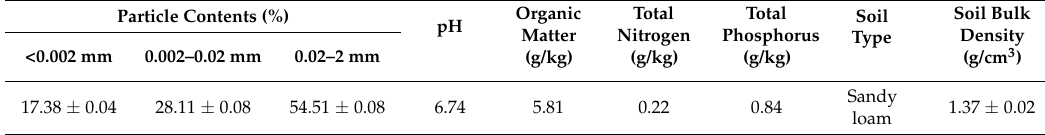
Table 1. Soil physical and chemical properties (mean of 5 samples).